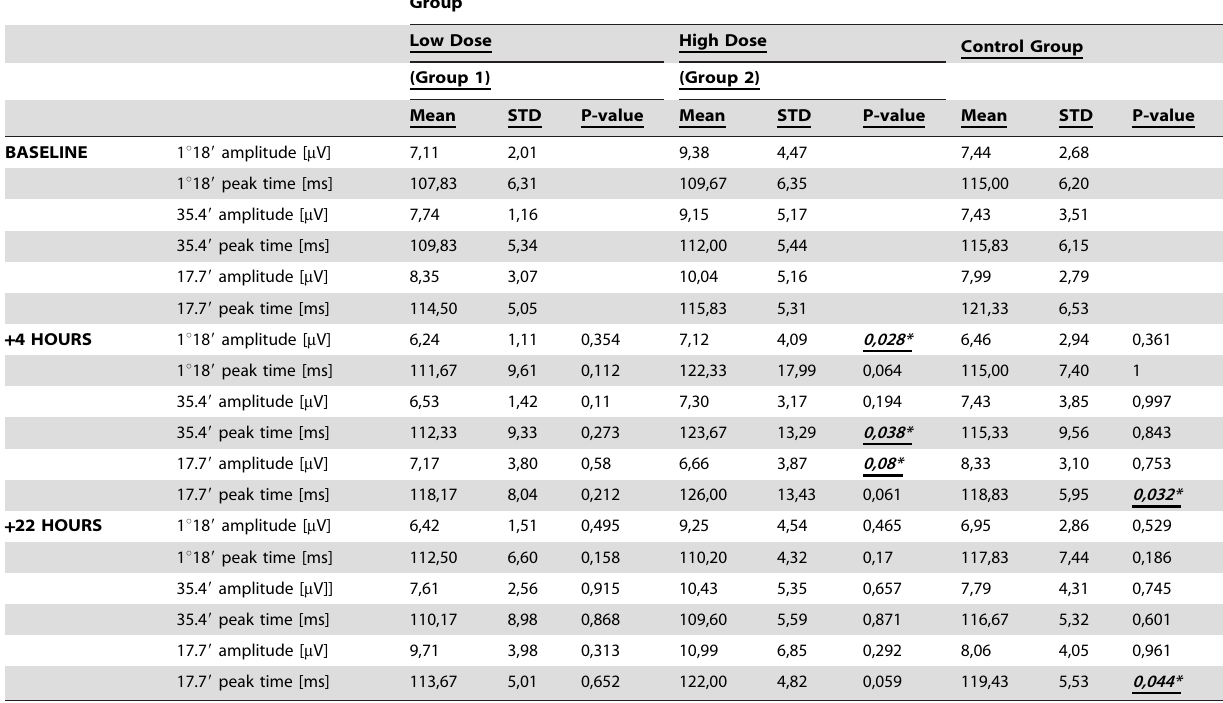
Group Low Dose High